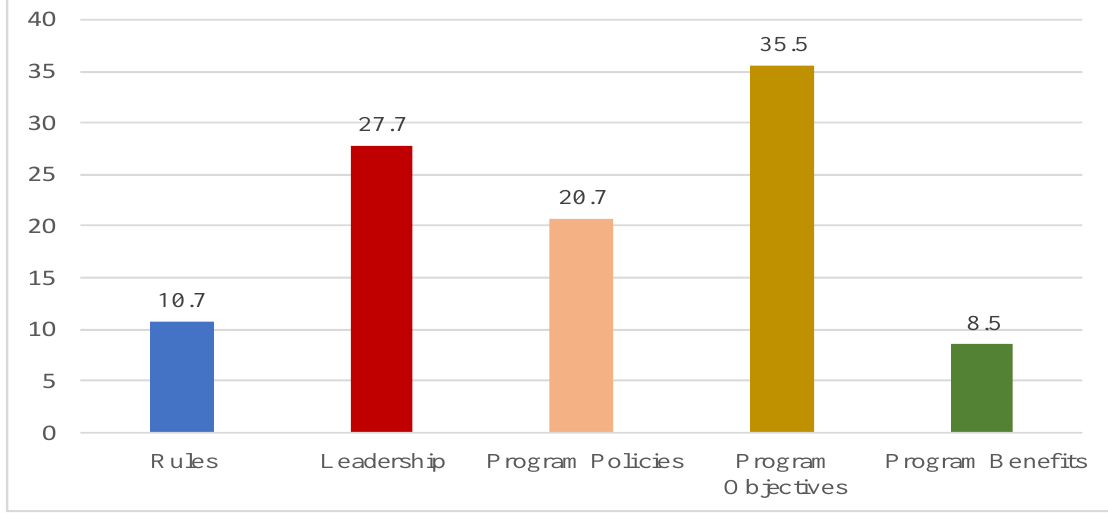
Figure 2: Institutional Determinants in Locally Fully Funded Development Programs Source: Field Survey,